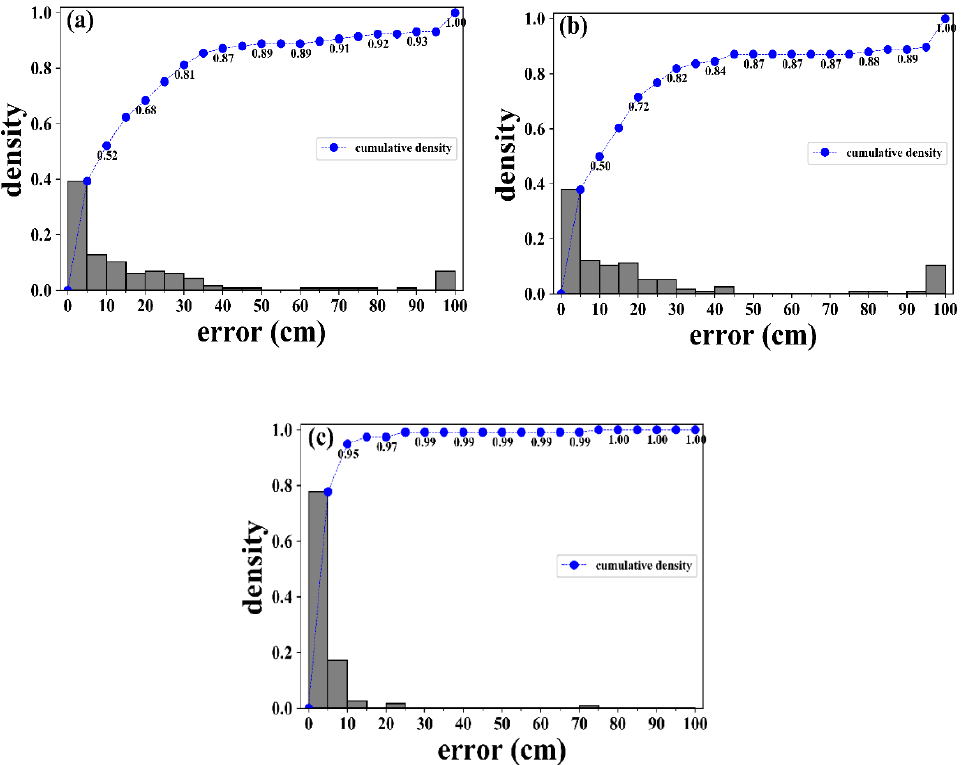
Figure 10. Distribution of the impact localization errors on the aluminum plate using ( a ) the amplified spontaneous emission (ASE) scheme / Single Fiber Bragg grating (FBG) sensors; ( b ) the ring laser scheme / Single FBG sensors; ( c ) the ASE scheme / FBG rosette sensors.